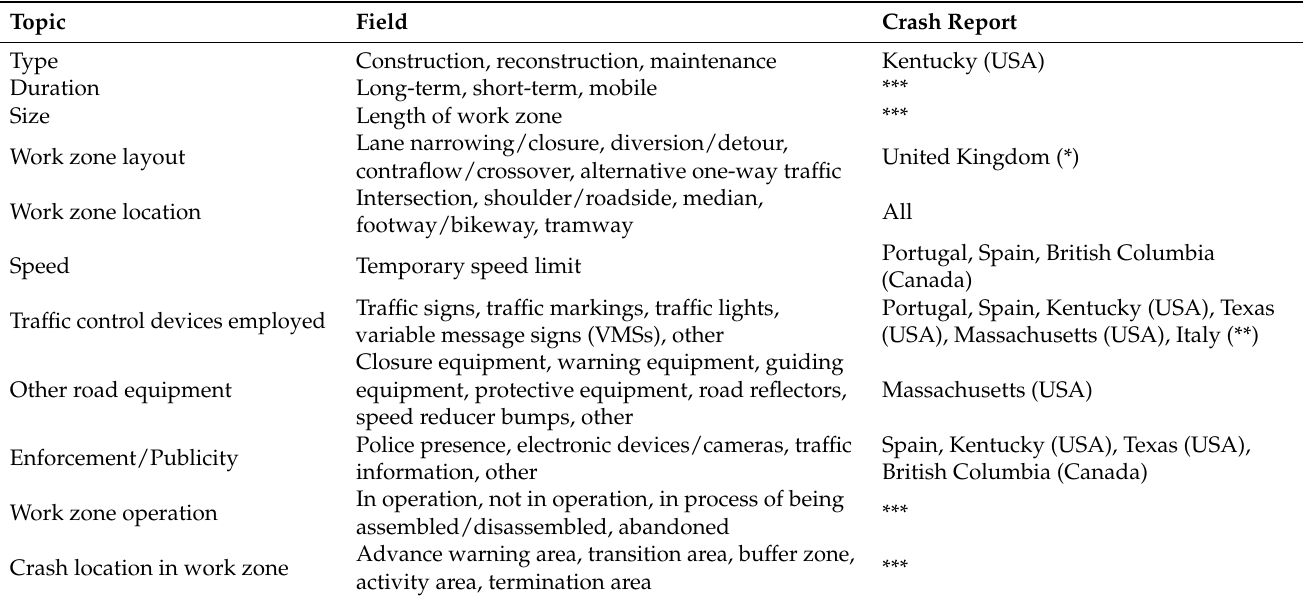
Table 1. Information for analysis of crashes in work